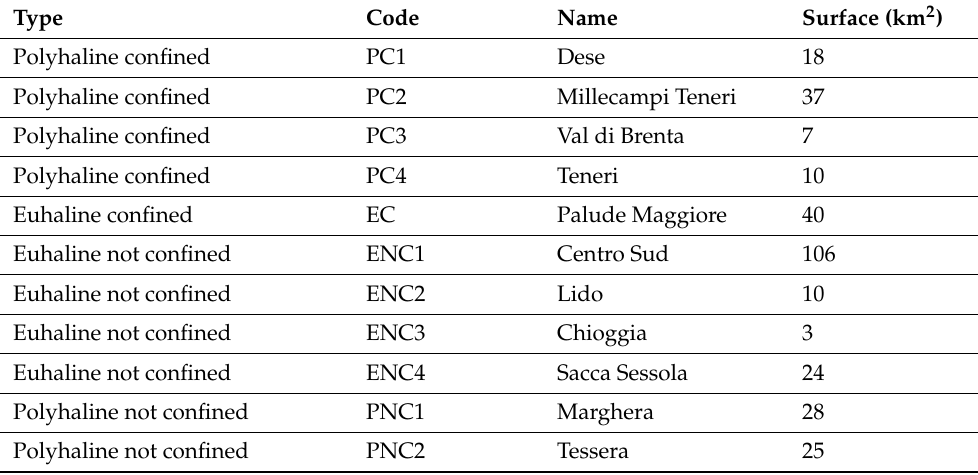
Table 1. Water body classification, where Polyhaline equals 18–30, Euhaline >